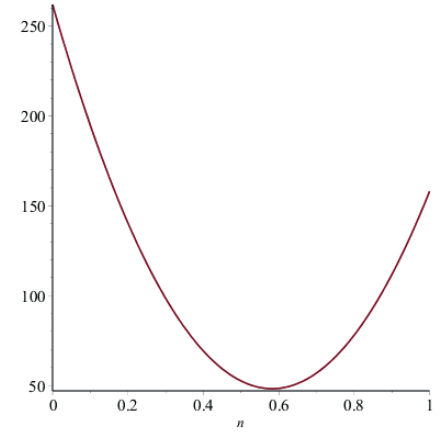
Figure 18: Plot of R